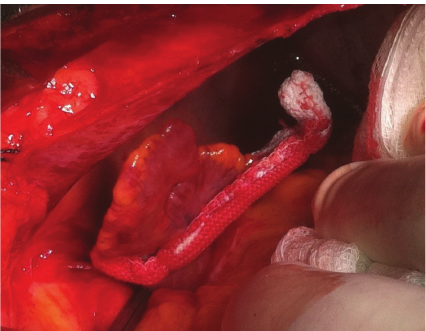
Figure 3: New clip device to close the left atrial appendage through sternotomy or thoracoscopic